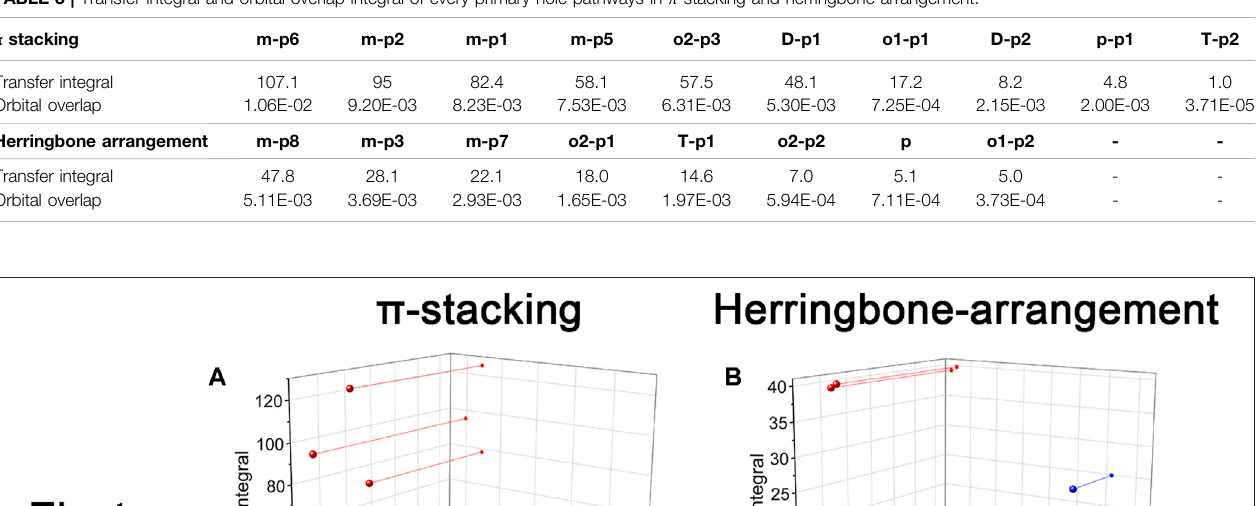
Frontiers in Chemistry |